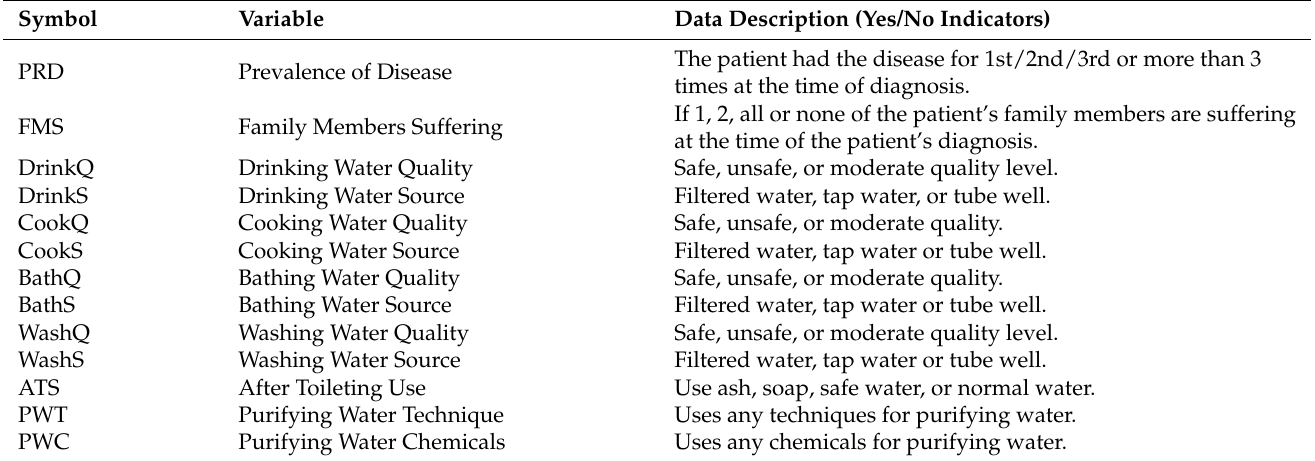
Table 4. Data variables indicators on patient’s living